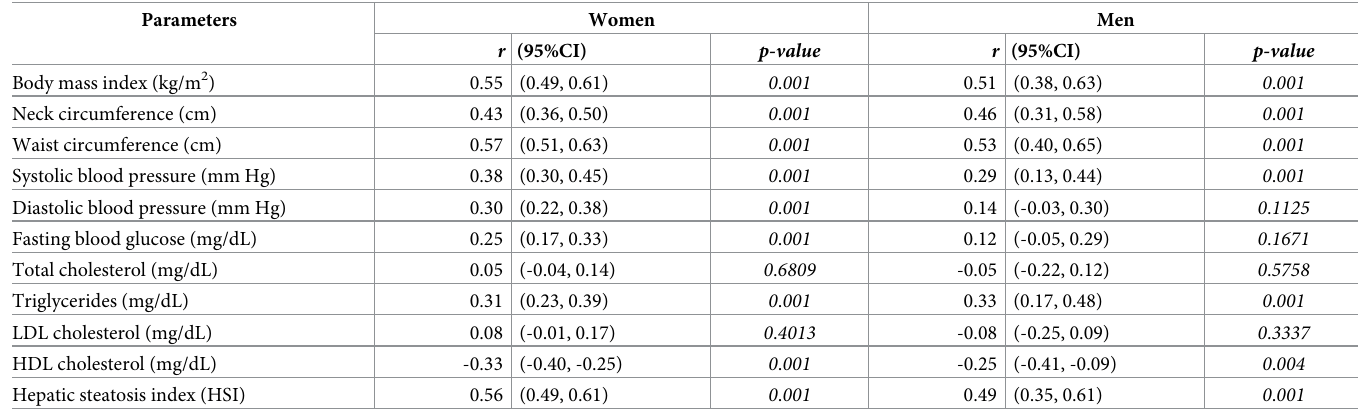
Table 2. Correlation between the controlled attenuation parameter (CAP) quantifying liver steatosis and metabolic syndrome parameters, stratified by gender.